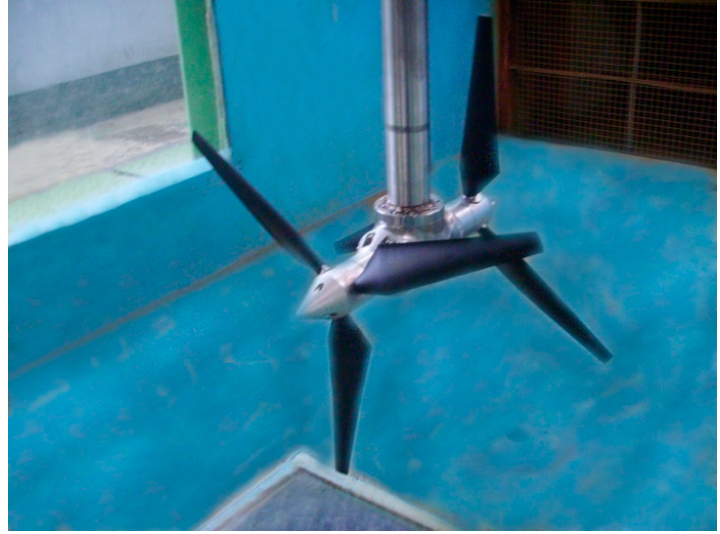
Figure 1. Small Scale model of the counter-rotating marine current turbine.